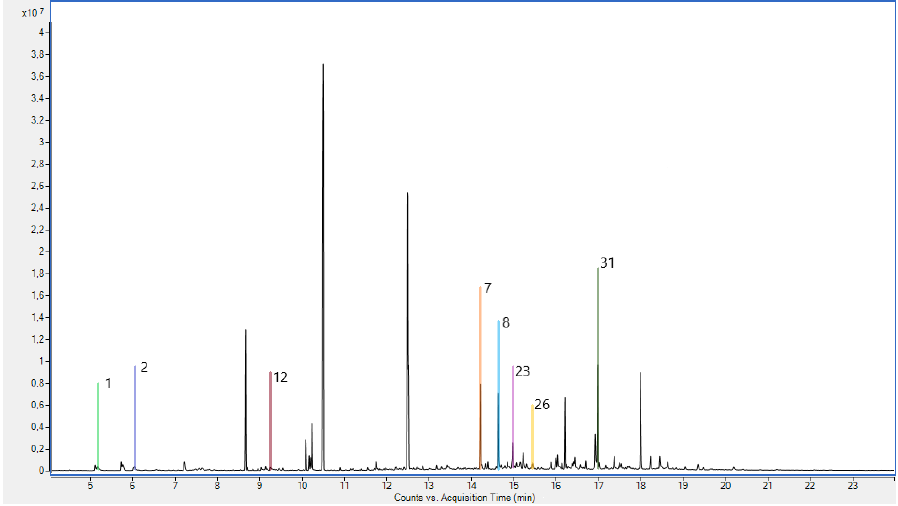
Figure 3. Chromatogram of DCM extraction of sample W with # ID.